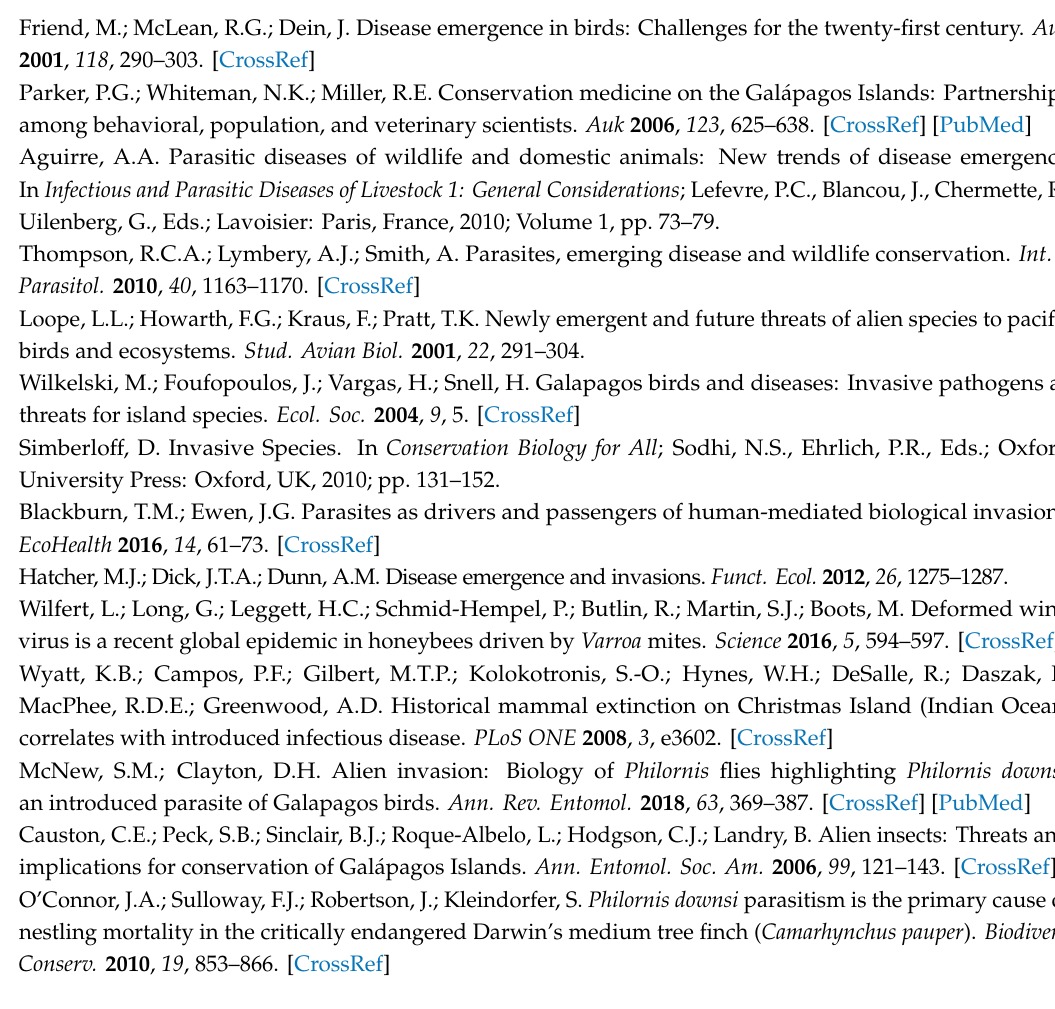
Table S1: Recipes for Trypanosomatidae PCR tests, Table S2: 18S rRNA gene sequences from P. downsi samples generated during this study, Table S3: 18S rRNA gene sequences used in phylogenetic analyses, including sequences obtained from P. downsi samples from our study and known reference sequences from